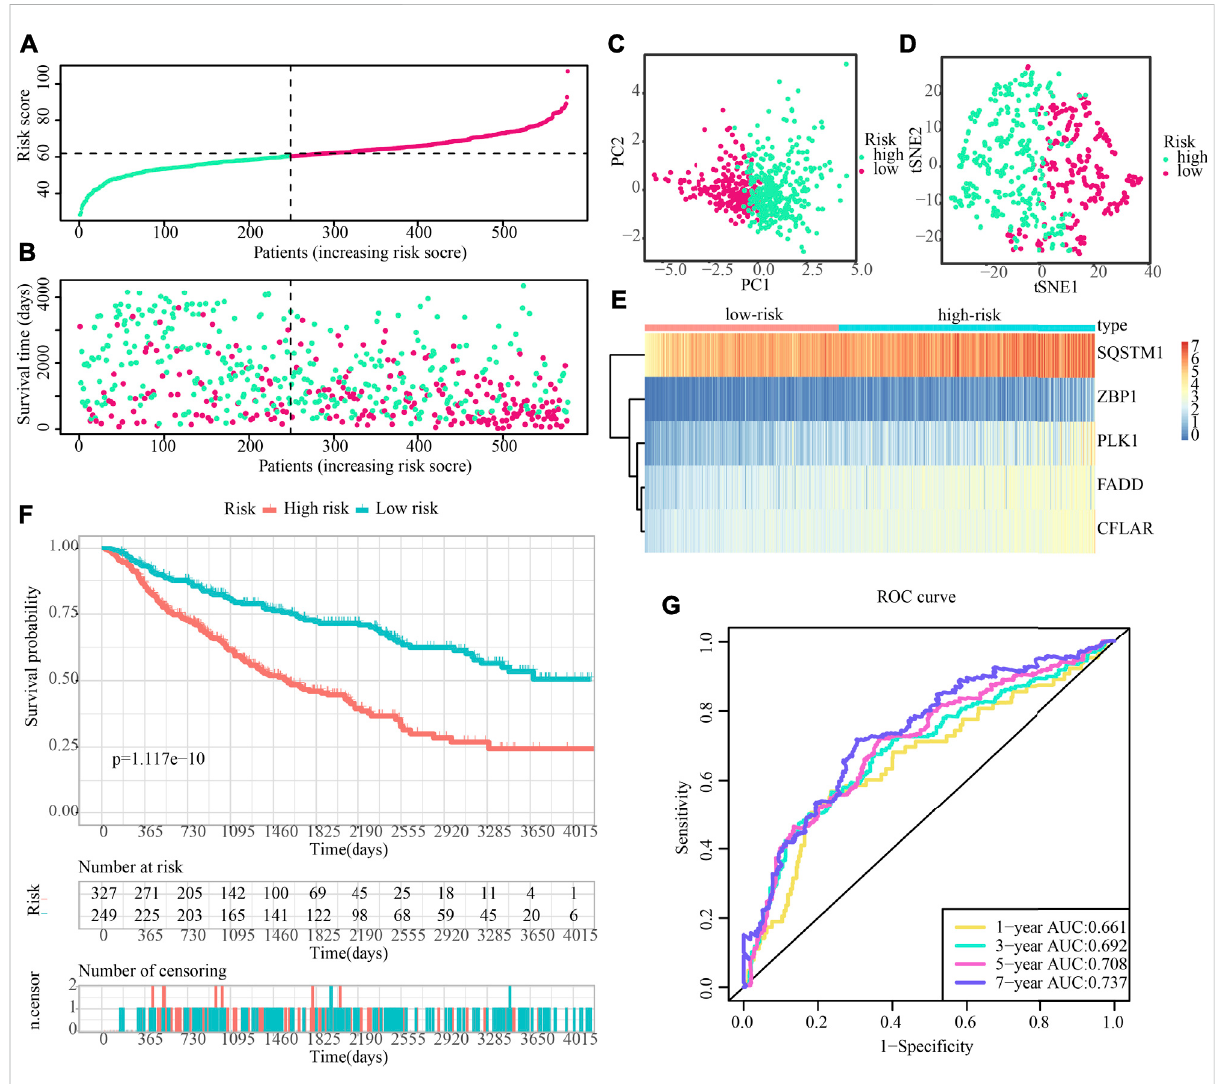
FIGURE 11 The predictive performance of the risk score was validated by the validation cohort. (A) Group division in the validation cohort. (B) High-risk patients exhibited an increased incidence of death. (C,D) PCA and t-SNE analysis demonstrated an excellent clustering performance of the fi